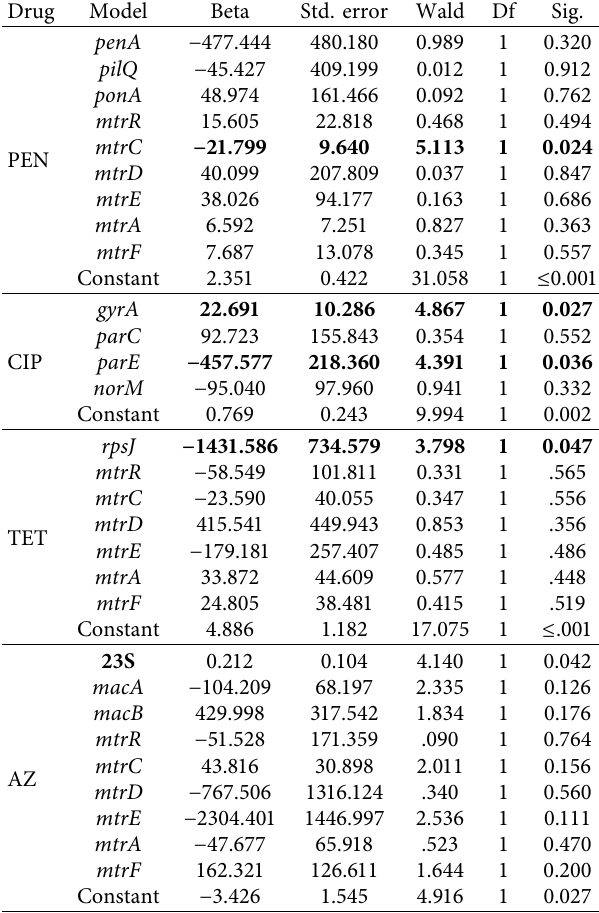
Table 2: Statistically significant logistic regression models of genes associated with AMR as determined by EUCAST MIC